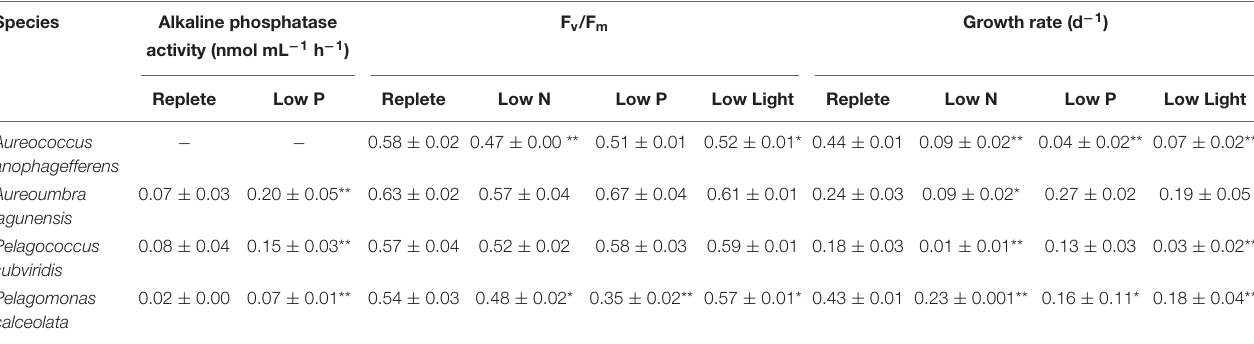
TABLE 1 | Alkaline phosphatase activity, photosynthetic efficiency (F v /F m ) and growth rate for 3 days at the exponential stage. Species